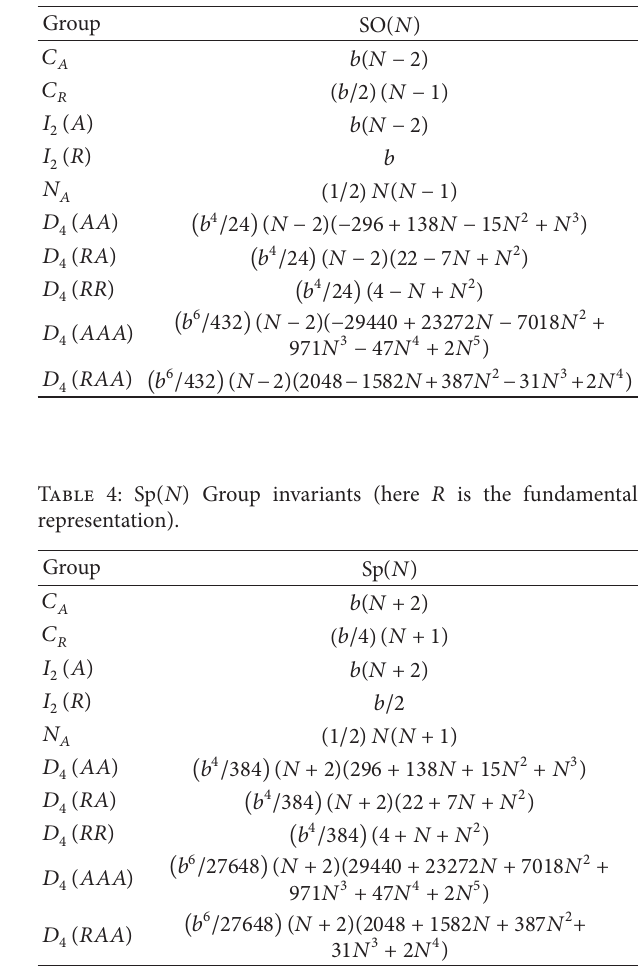
Table 2: SU (𝑁) Group invariants (here 𝑅 is the fundamental representation).